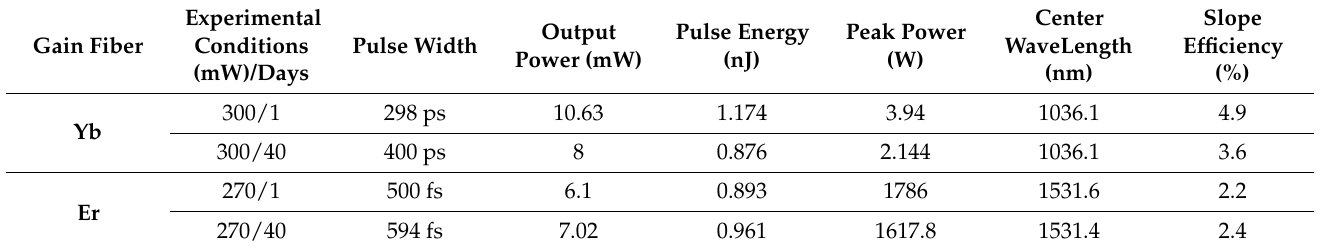
Table 1. Comparison of data before and after the two experiments.